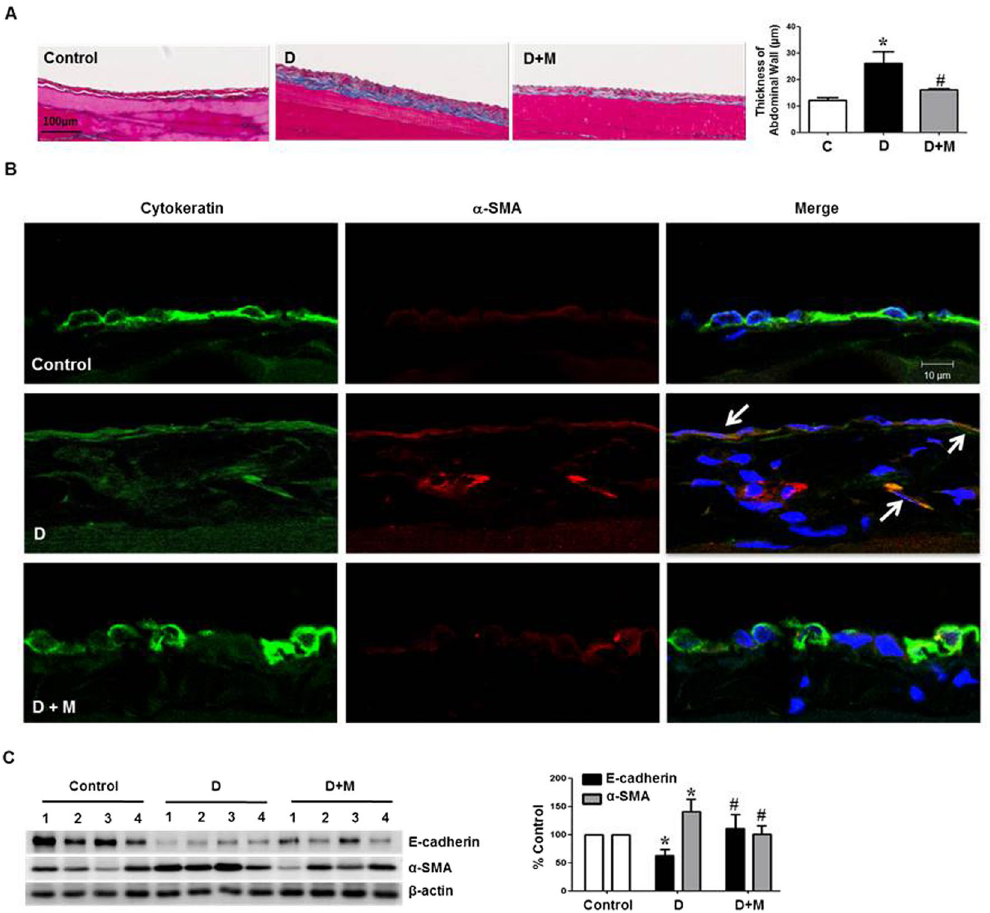
Figure 9. Effect of Metformin on Peritoneal Fibrosis and EMT in Animal Model of Peritoneal Dialysis. ( A ) Masson’s Trichrome-stained tissue of parietal peritoneum shows that peritoneal thickness in dialysis group (D) is significantly higher than those in control group, which is decreased in group D + M. Representative histology of parietal peritoneum is shown with quantitation bar of peritoneal thickness. Magnification × 200. Scale bar 100 μ m. * p < 0.05 vs. others, # p < 0.05 vs. group D. ( B ) Representative fluorescent confocal image of peritoneum shows a decreased cytokeratin (green) and increased α -SMA staining (red) in mesothelial lining with an appearance of cytokeratin ( + )/ α -SMA ( + ) cells in mesothelial and submesothelial zone (arrows). Rats in group D + M demonstrates a restoration of cytokeratin ( + ) mesothelial cells with a decrease in cytokeratin ( + )/ α - SMA ( + ) cells in mesothelial and submesothelial area. Magnification × 640. Scale bar 10 μ m. ( C ) Western blot analysis with quantitation bar shows the changes of E-cadherin and α -SMA in group D are ameliorated by metformin treatment. * p < 0.05 vs. others, # p < 0.05 vs. group